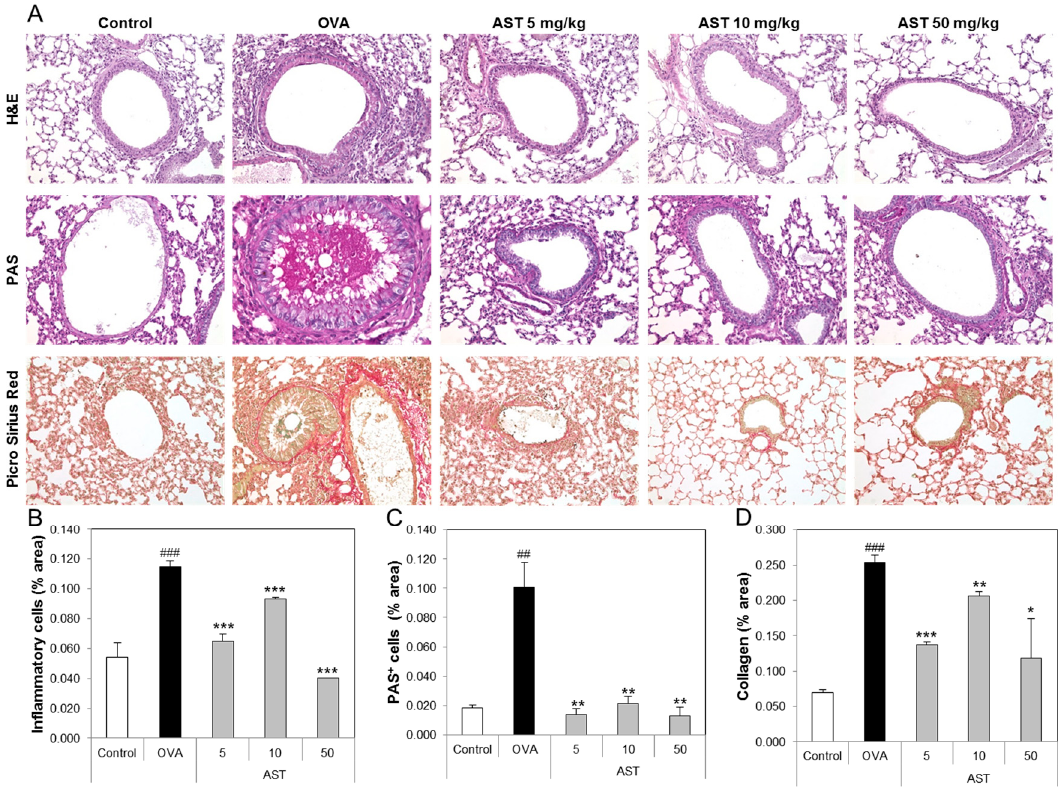
Figure 5. Effect of AST on histology of lung tissue in OVA-induced murine model of asthma. The C57BL/6 mice were sensitized and challenged with OVA for asthma induction. At the end of the experiment, the mice lungs were removed. ( A ) The lungs were stained by H&E (×200), PAS (×200), and Picro Sirius Red. The percentages of ( B ) inflammatory cells, ( C ) PAS positive cells, and ( D ) collagen in the lung sections were measured via Image J program. The data represent three mice per group. All data were expressed as means ± SD. ### p < 0.001 and ## p < 0.01 control vs. OVA. * p < 0.05, ** p < 0.01 and *** p < 0.001 OVA group vs. AST group. H&E: hematoxylin-eosin staining, PAS: Periodic acid-Schiff staining.